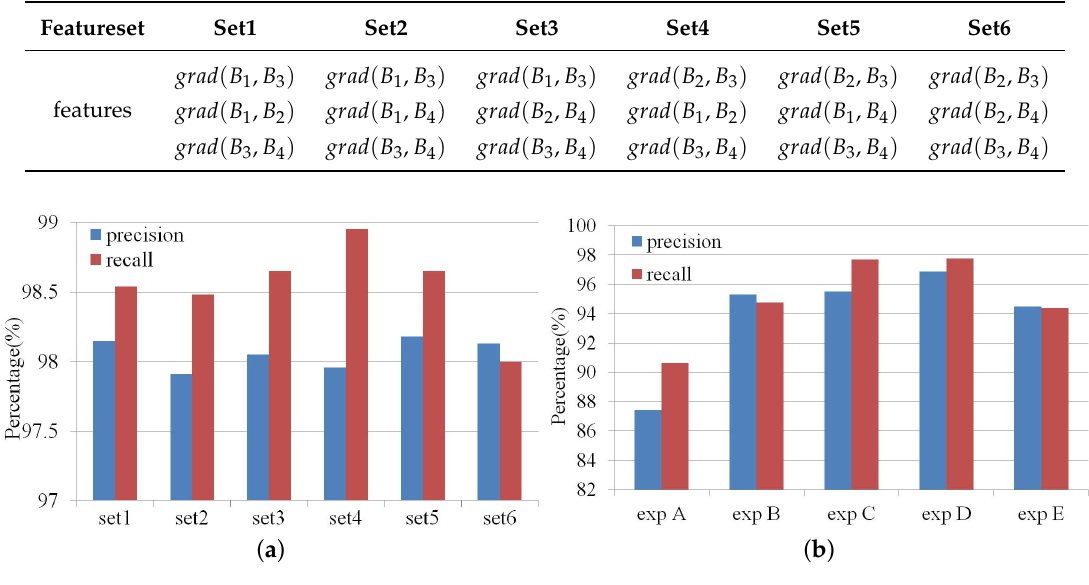
Figure 8. ( a ) Performance of classification based on every feature set and ( b ) performance of classification based on LFNet with/without color image input with different band